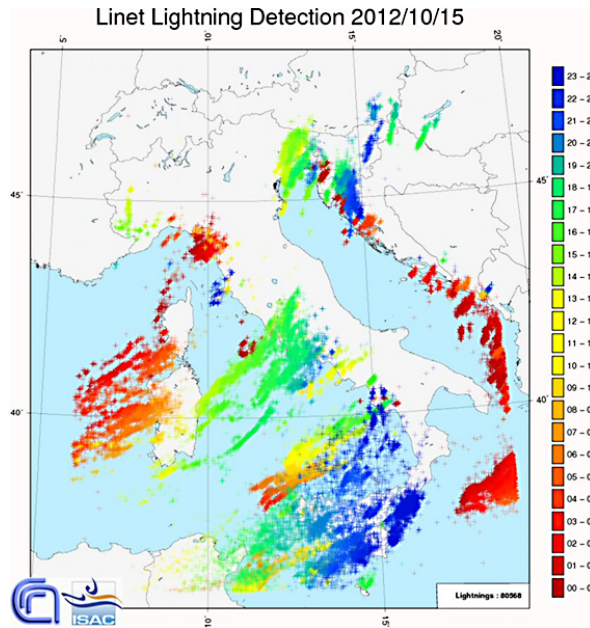
Figure 11. LINET lightning activity measured on 15 October 2012. The map shows the intra-cloud and cloud-to-ground strikes regis- tered in 24h. Different colors are associated with different